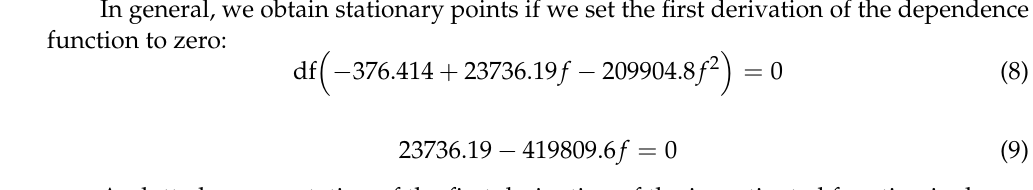
Figure 19. Course of dependence of the number of holes drilled up to the moment of tool damage in the range of the feed rates used.